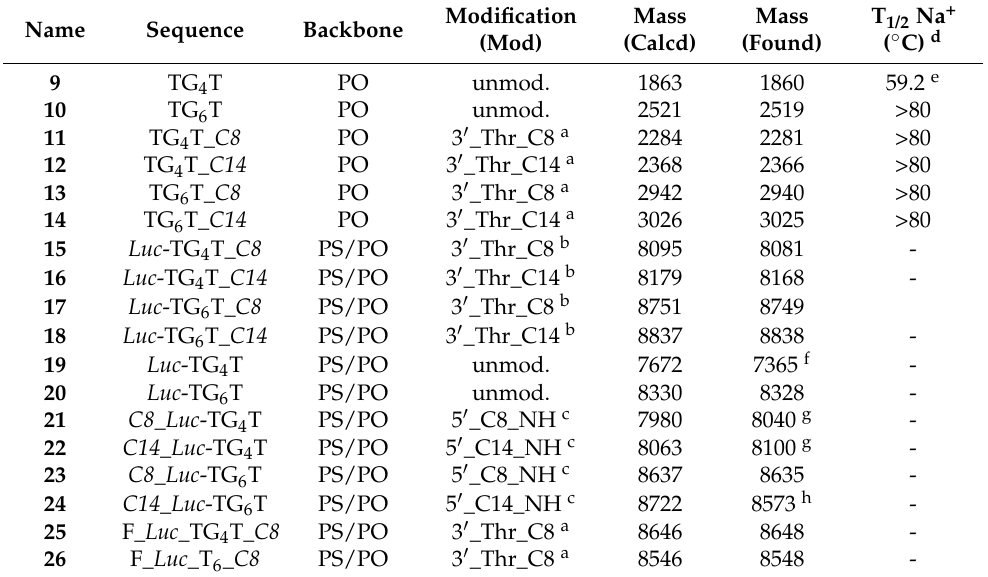
Table 1. Sequences and characterization data (MALDI-TOF mass spectrometry) of